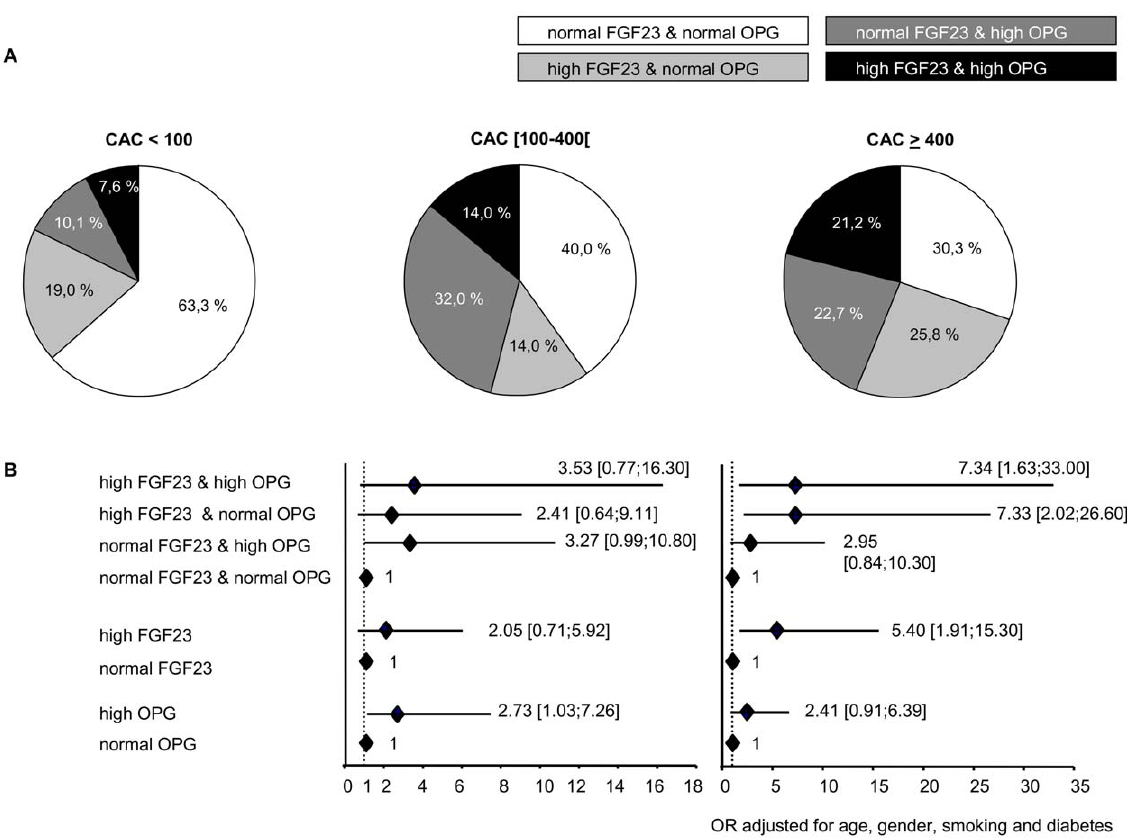
Figure 2. Fibroblast growth factor 23 and Osteoprotegerin are differently associated to the severity of CAC. (A) Proportions of patients with normal ( , 173.30 RU/mL) or high ( $ 173.30 RU/mL) fibroblast growth factor 23 (FGF23) and normal ( , 10.71 pmol/L) or high ( $ 10.71 pmol/L) osteoprotegerin (OPG) levels within each coronary artery calcification (CAC) category. Sections of pie charts indicate proportions of patients with FGF23 and/or OPG levels by CAC category. (B) Prevalence rate ratio of CAC associated with increased levels of FGF23 and/or OPG levels.